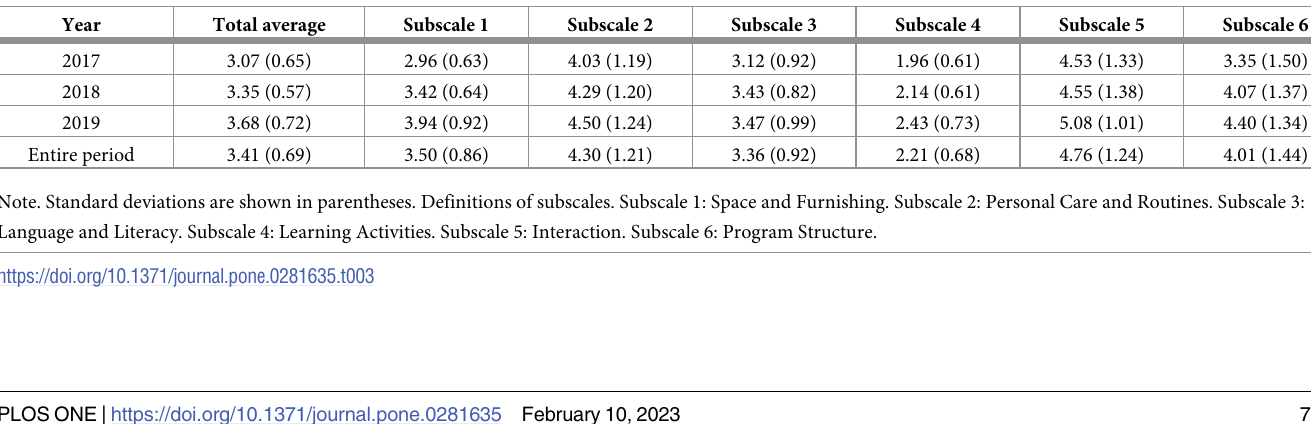
Table 3. The mean total average score and mean scores of each